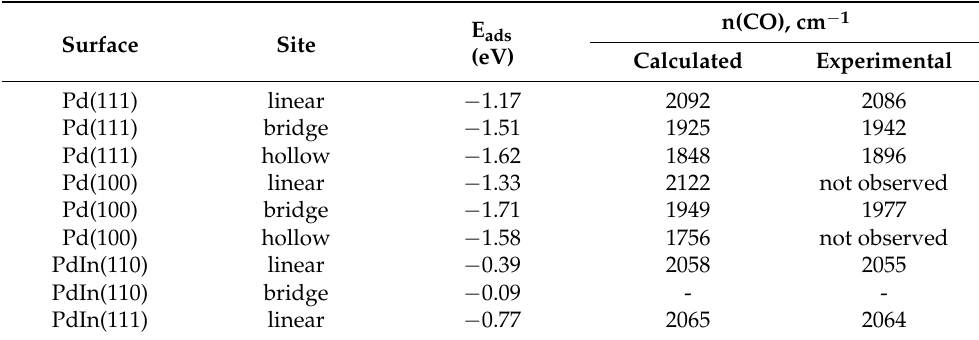
Table 2. DFT calculated CO adsorption energies and wavenumbers for various adsorption sites on the Pd and PdIn